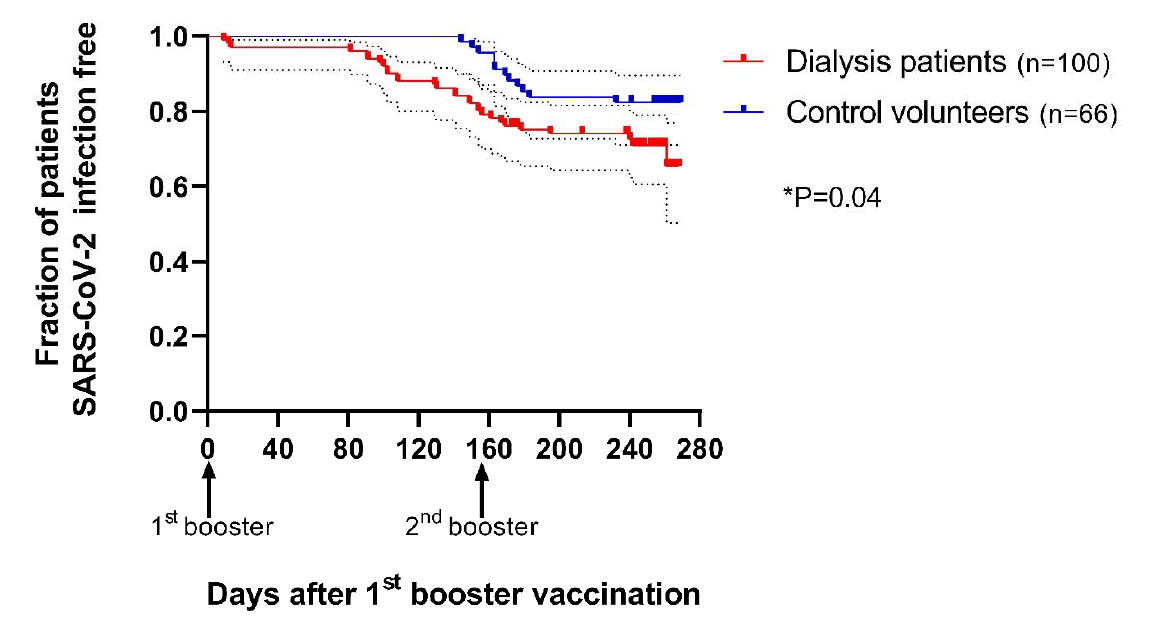
Figure 1. The infection rate was significantly higher in the dialysis patients after the booster dose. Fraction of 100 dialysis patients (red) and 66 control volunteers (blue) with SARS ‐ CoV ‐ 2 infection after the first booster vaccination (95% CI).